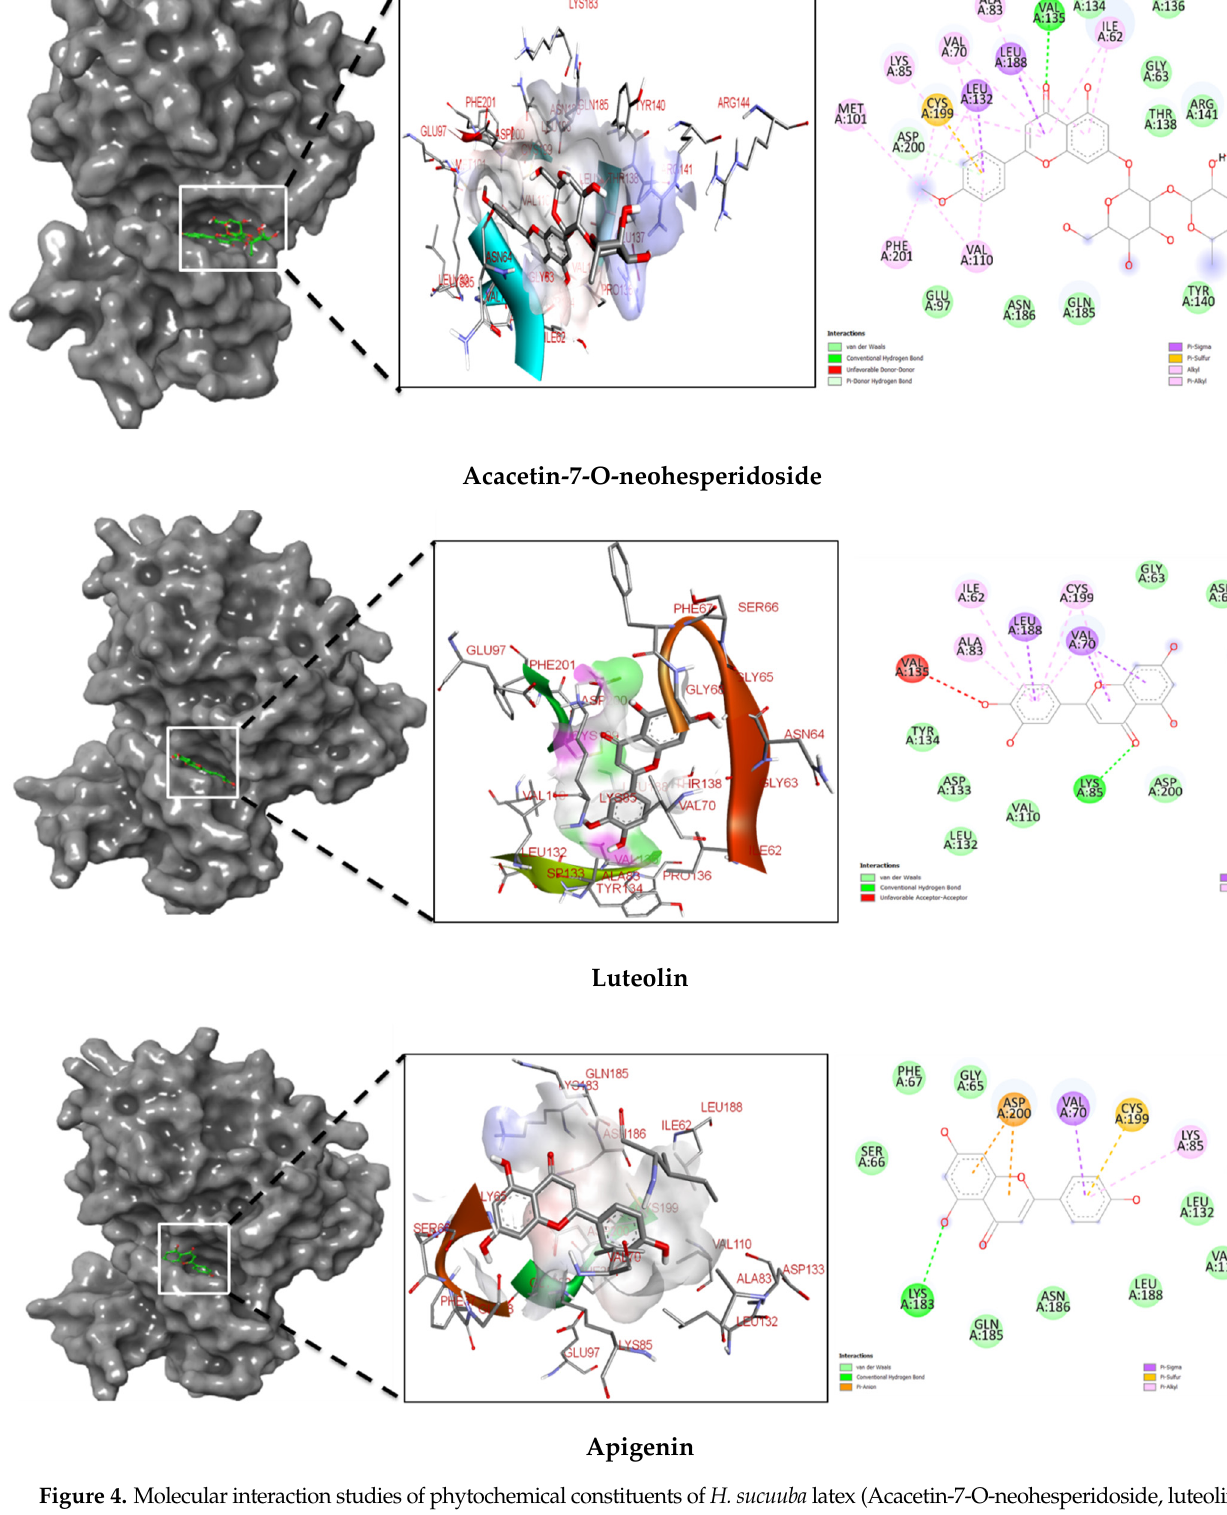
(Left panel), and 2D (Right panel) interactions.